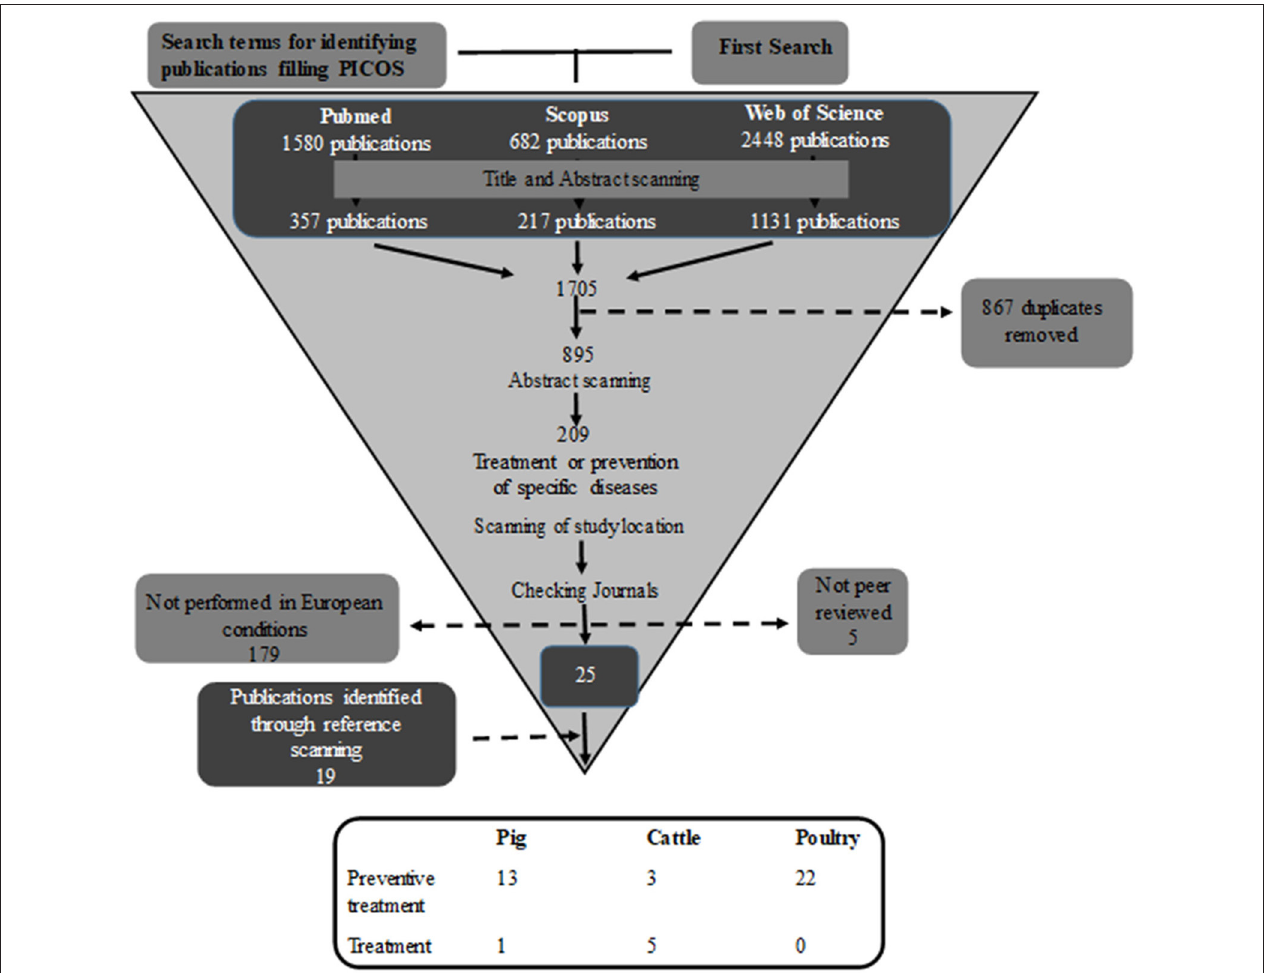
FIGURE 1 | Search process for identifying publications where phytotherapeutic remedies are used to treat/prevent